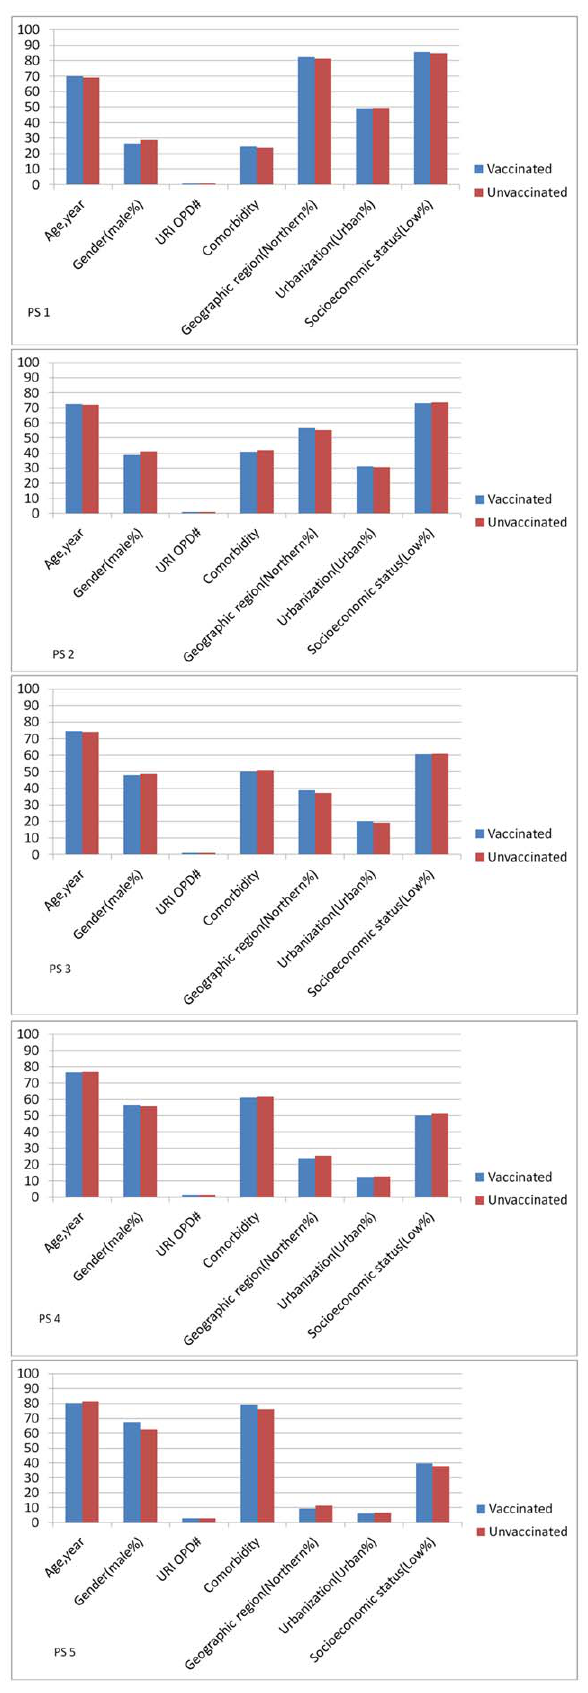
Figure 1. Distribution of explanatory variables between patients receiving influenza vaccine and those not receiving influenza vaccine for propensity score quintiles ranging from 1 (least likely to receive influenza vaccine) to 5 (most likely to receive influenza